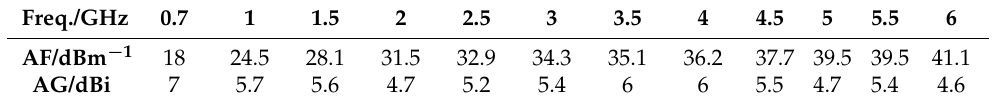
Figure 19. Presentation of the simulated and measured antenna factor in dBm − 1 versus frequency. Table 2. Illustration of optimum values of the antenna factor and corresponding gain versus